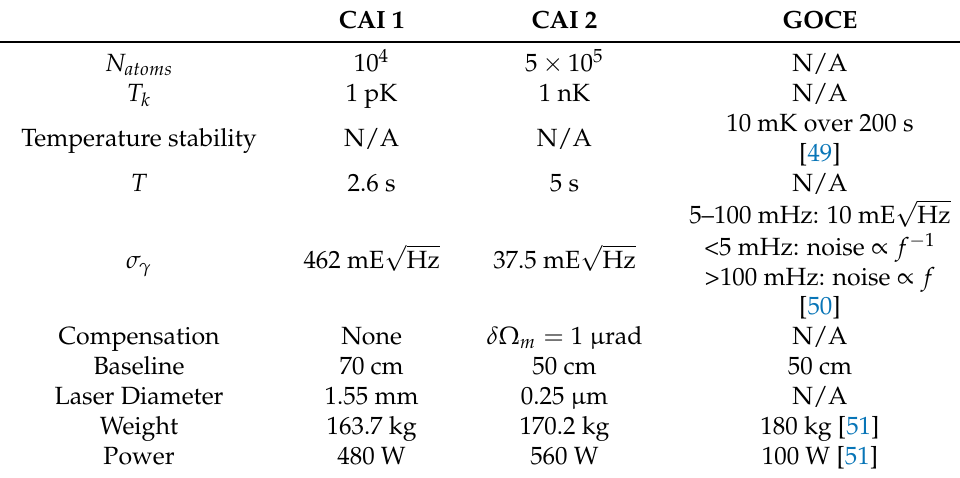
Table 3. CAI-based gradiometer configurations, compared with